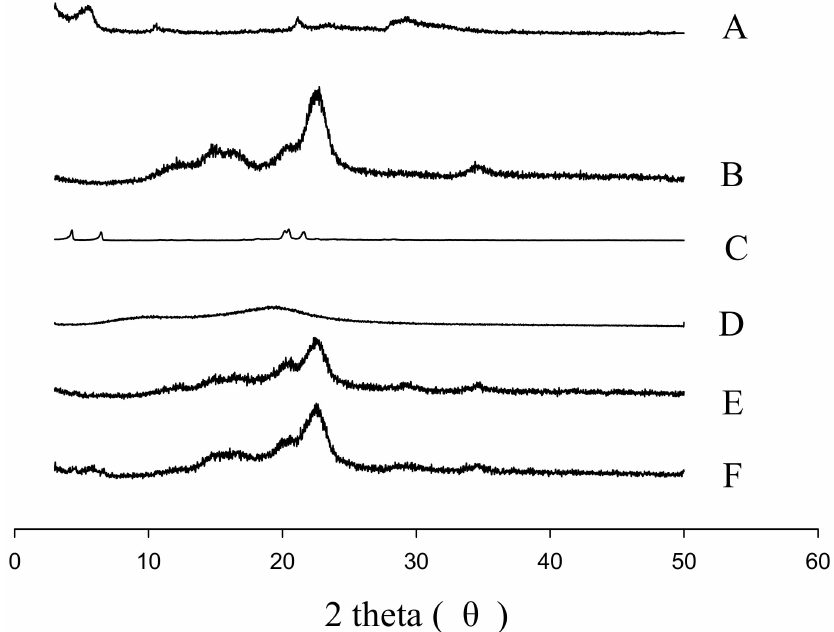
Figure 7. PXRD patterns: ( A ) calcium silicate; ( B ) MCC; ( C ) SLS; ( D ) HPMC; ( E ) SEGS; ( F ) SNEDDS.